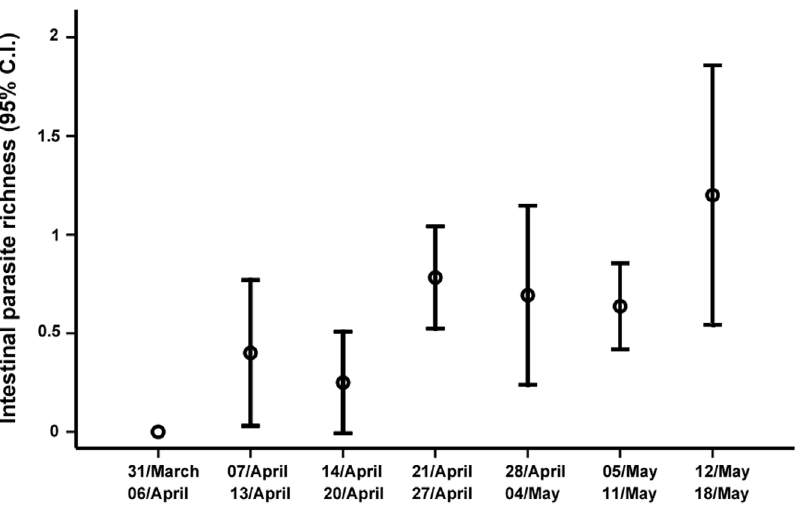
Figure 1. Changes in intestinal parasite richness. Mean and 95% confidence interval for intestinal parasite richness in the seven weeks of the study period.